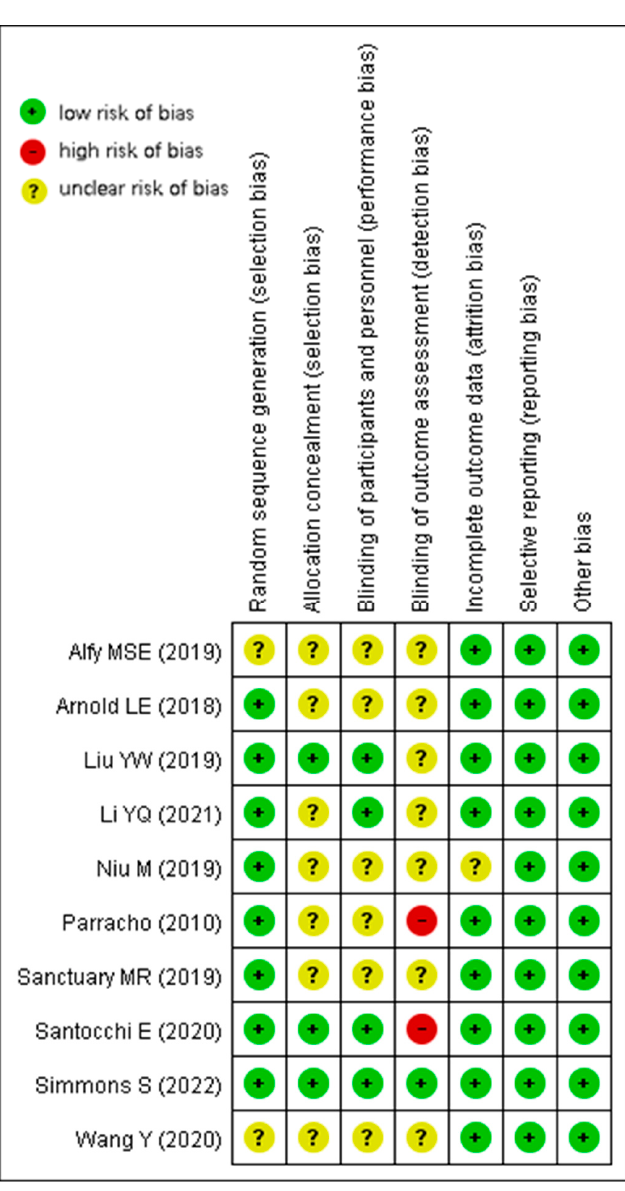
Figure 2. Risk of bias graph for RCTs and crossover controlled trials [23–32].